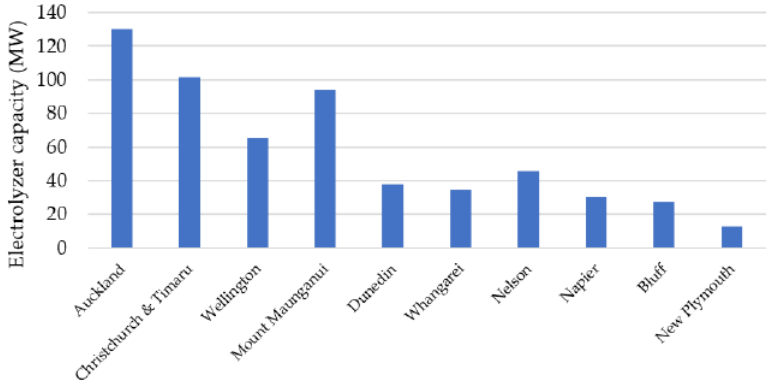
Figure 3. Electrolyser capacity per regional port.